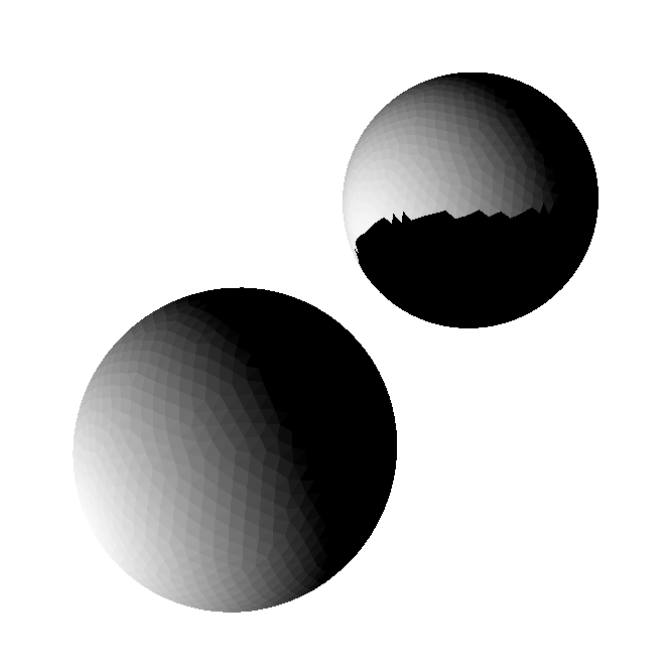
Figure 11. Shadowing of two spheres of radius 1200 km, each. Spheres are located at ( 0,0,0) and ( − 3000,1000,500 ) , respectively. Direction to the sun is ( 1 m ,0,0 ) . The blocky appearance of the shadow is a result of the discretization of the shadowed sphere.